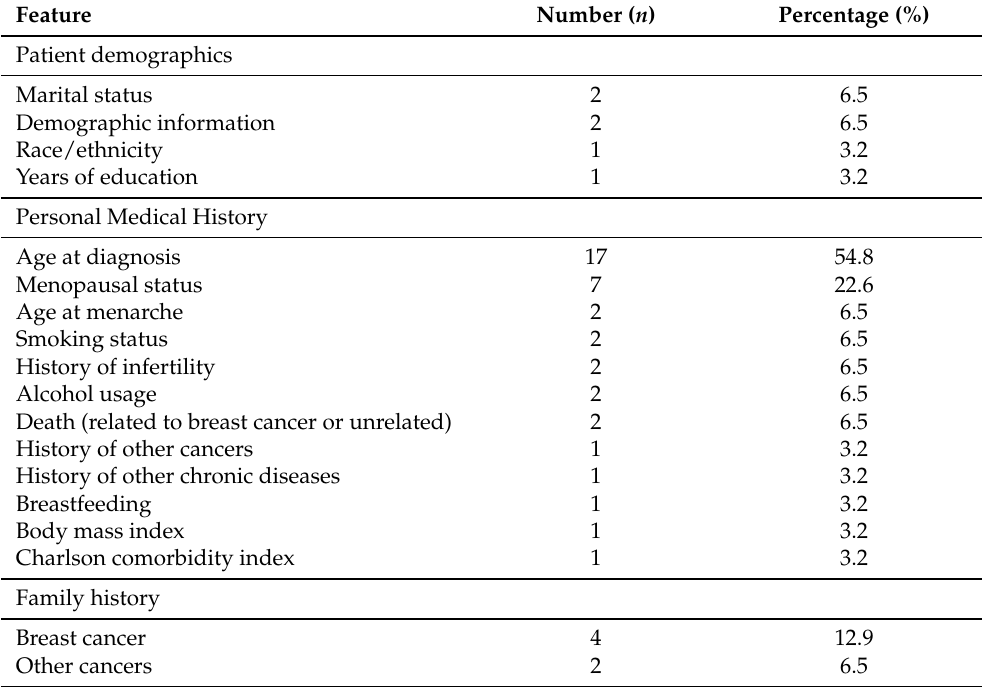
Table 3. Feature predictors used based on patient information. n corresponds to the number of studies using each feature; % is n /31 × 100, 31 being the total of studies included in this review. Feature Number ( n ) Percentage